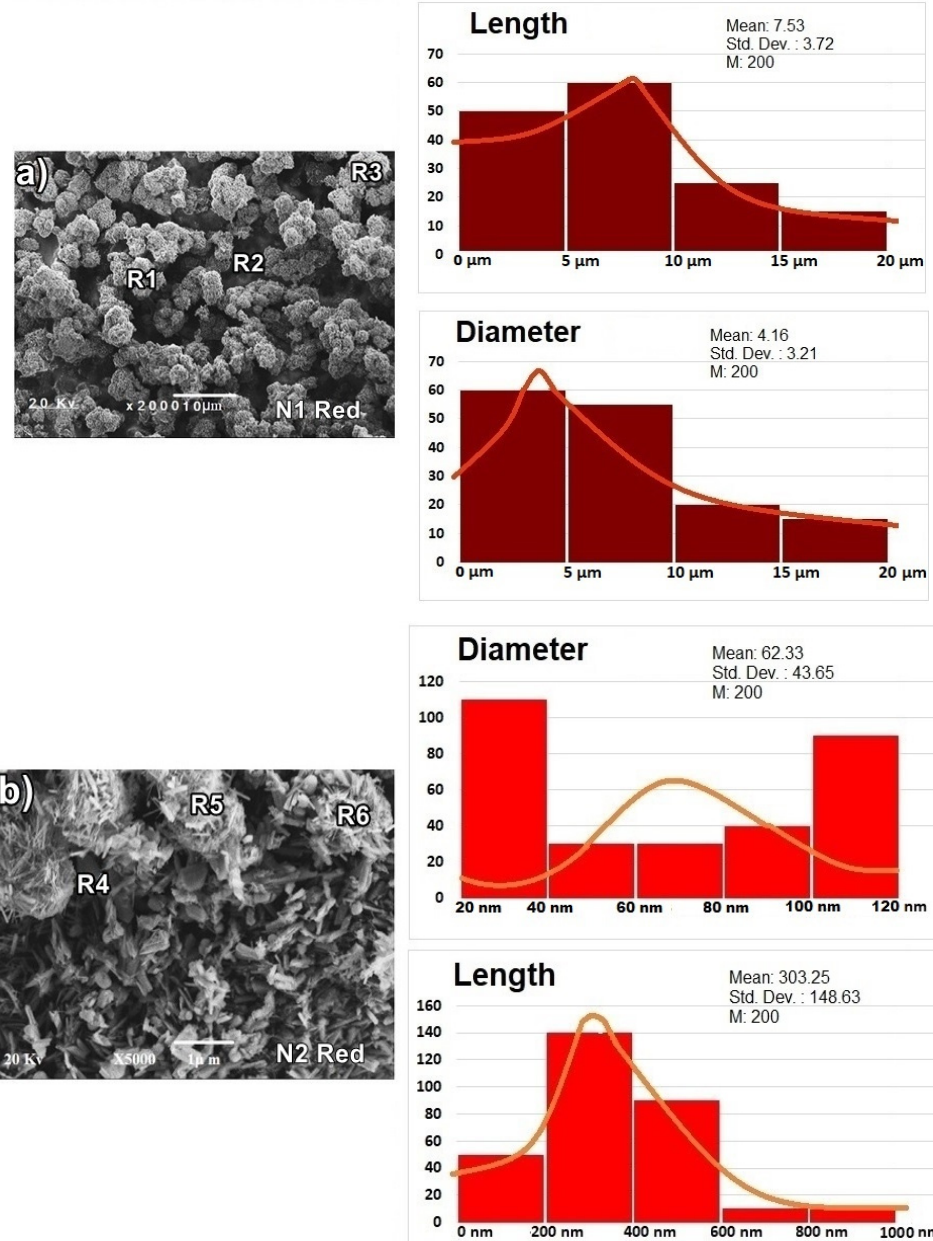
Figure 4. Red pigment micrographs showing localized areas for EDS analysis and size classes: ( a ) N1 Red, and ( b ) N2 Red. Table 3. Elemental composition (wt%) determined through EDS of the red samples. Sample